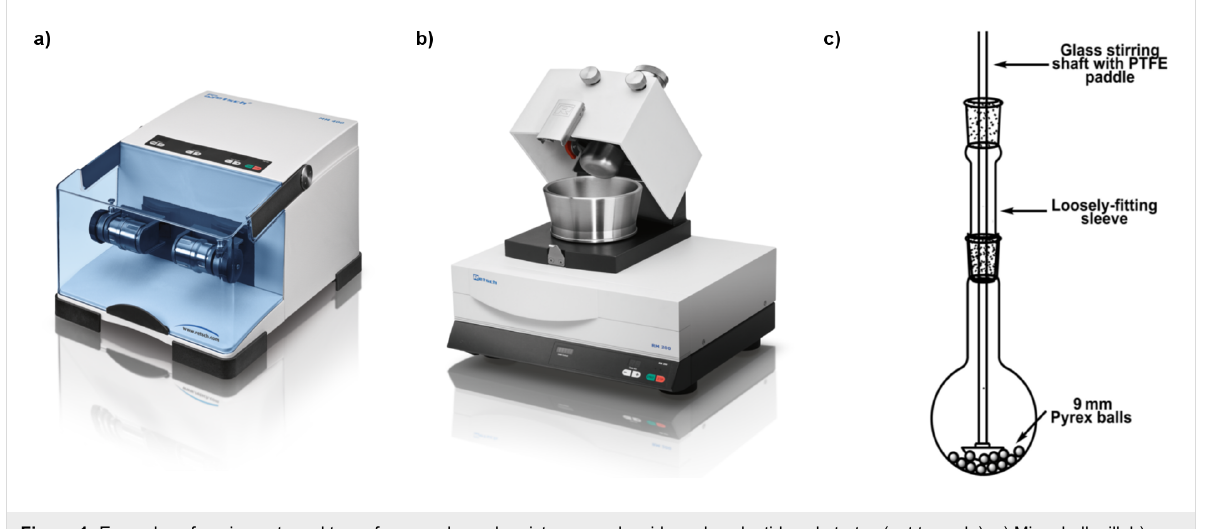
Figure 1: Examples of equipment used to perform mechanochemistry on nucleoside and nucleotide substrates (not to scale). a) Mixer ball mill; b) mortar grinder; c) improvised attritor [19]. Figures a) and b) are reused with the permission of Retsch (https://www.retsch.com); c) is adapted with permission from [19], copyright 2006 American Chemical